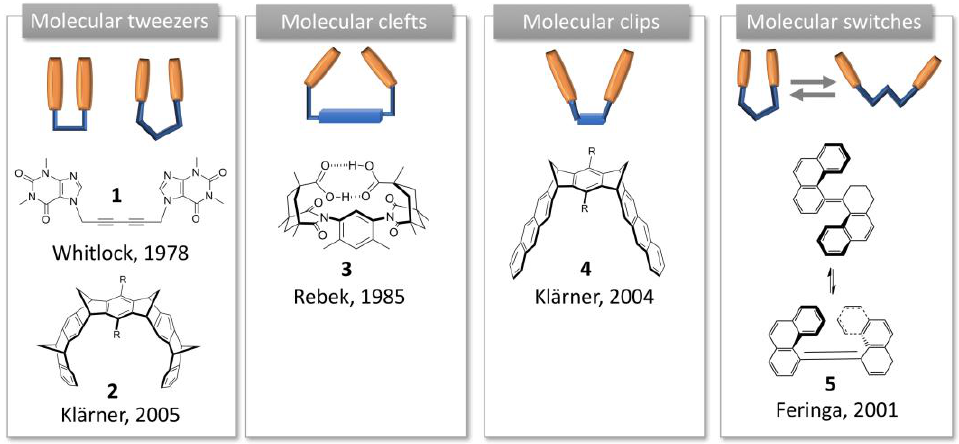
Figure 1. Schematic representation of the molecular tweezers, clefts, clips and switches introduced to describe acyclic synthetic receptors, and their first reported examples.